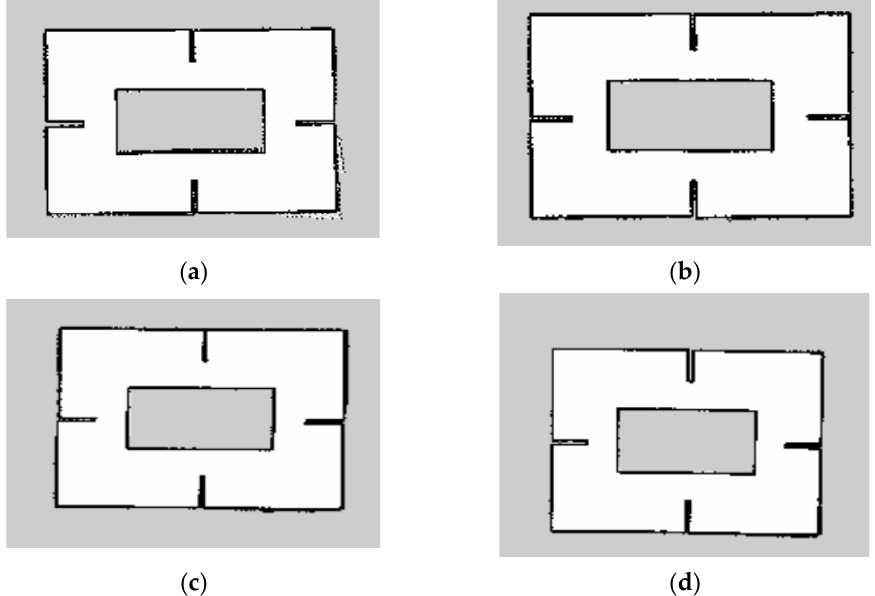
Figure 18. ( a ) The threshold for the number of particles is 20. ( b ) The threshold for the number of particles is 40. ( c ) The threshold for the number of particles is 60. ( d ) The threshold for the number of particles is 80. Table 5. Measurement data with a particle count of 20.